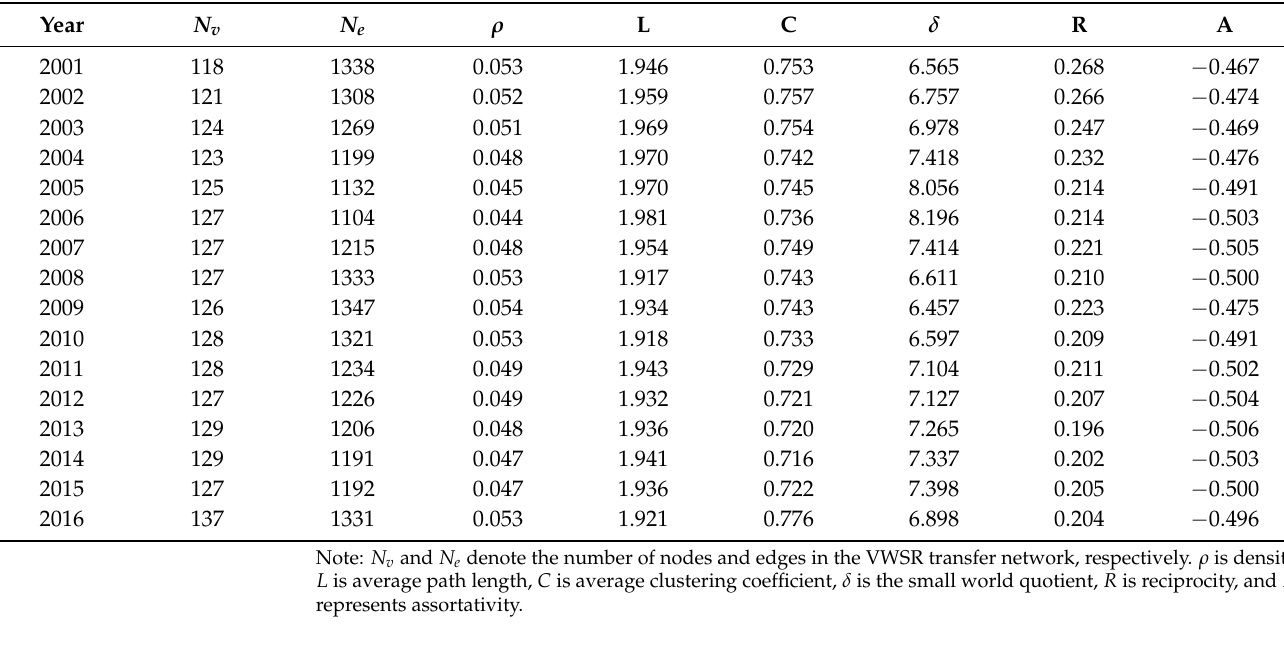
Table 2. Macro-level analysis of the VWSR transfer networks during 2001–2016.